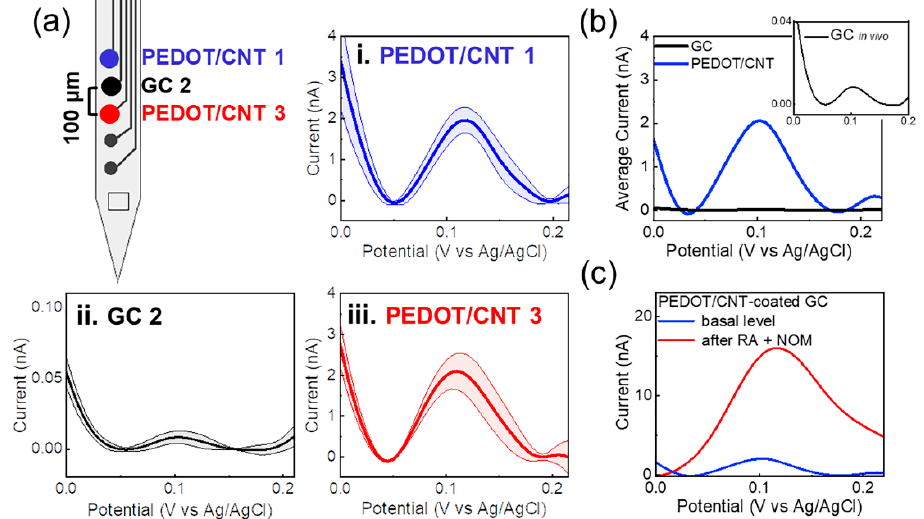
Figure 6. Multichannel detection of tonic dopamine concentrations using PEDOT/CNT-coated GC MEAs in the mouse DS. ( a ) Drawing of a 5-channel GC MEA with pointed out the electrode used for tonic DA detection, i.e., two PEDOT/CNT-coated microelectrodes ( i , iii ) and one uncoated GC microelectrode as a control ( ii ). ( i , iii ) Baseline-subtracted SWV DA peaks collected from two PEDOT/CNT-coated microelectrodes (basal level), ( ii ) baseline-subtracted SWV DA peaks collected from the uncoated GC microelectrodes; ( b ) baseline-subtracted SWV DA peaks collected at PEDOT/CNT-coated microelectrodes (blue) vs. GC microelectrodes (black, and magnification in inset); ( c ) representative baseline-subtracted SWV DA peaks collected at PEDOT/CNT-coated microelectrodes, before and 30 min after the administration of a cocktail of 2 mg/kg i.p. raclopride (RAC) and 20 mg/kg nomifensine (NOM).